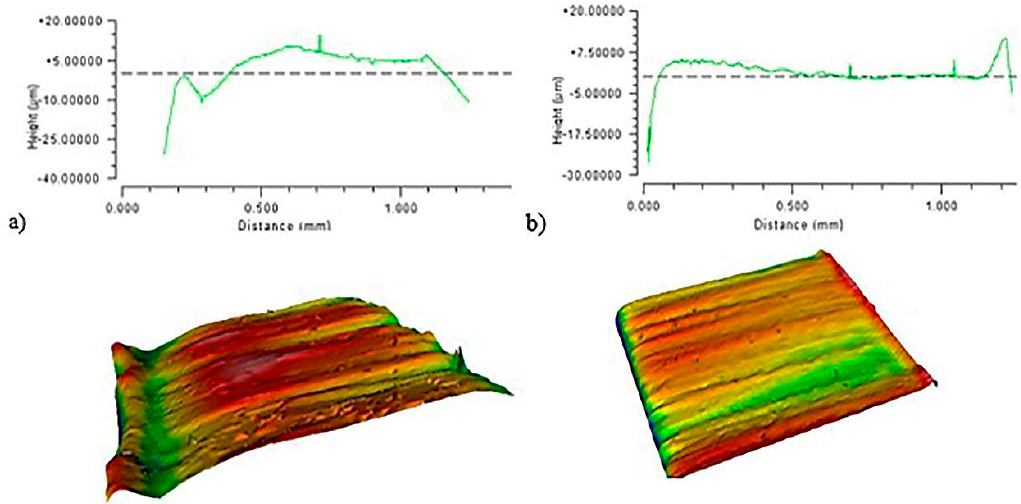
Figure 8. 2D profile and 3D map of the cutting area obtained by: ( a ) nonoptimized parameters, ( b ) optimized parameters.